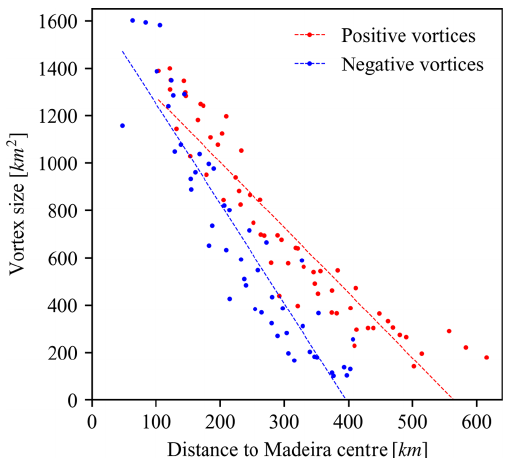
Figure 10. The size of four positive and four negative tracked vor- tices (see “Video supplement” V4, Gao et al., 2021) against their distance to the Madeira centre. Two dashed lines are fitted to the scatterplots to show different decaying rates of positive and nega- tive vortices.